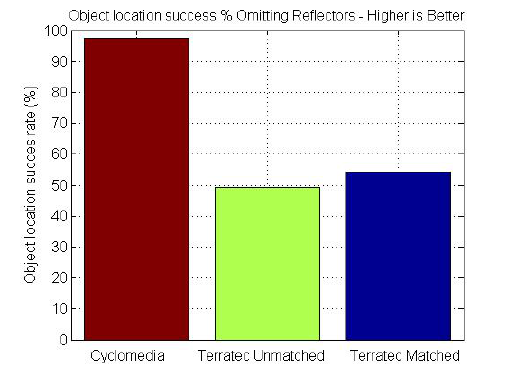
Figure 14: Cyclomedia and TerraTec solutions compared in the terms of the mean 3D positioning